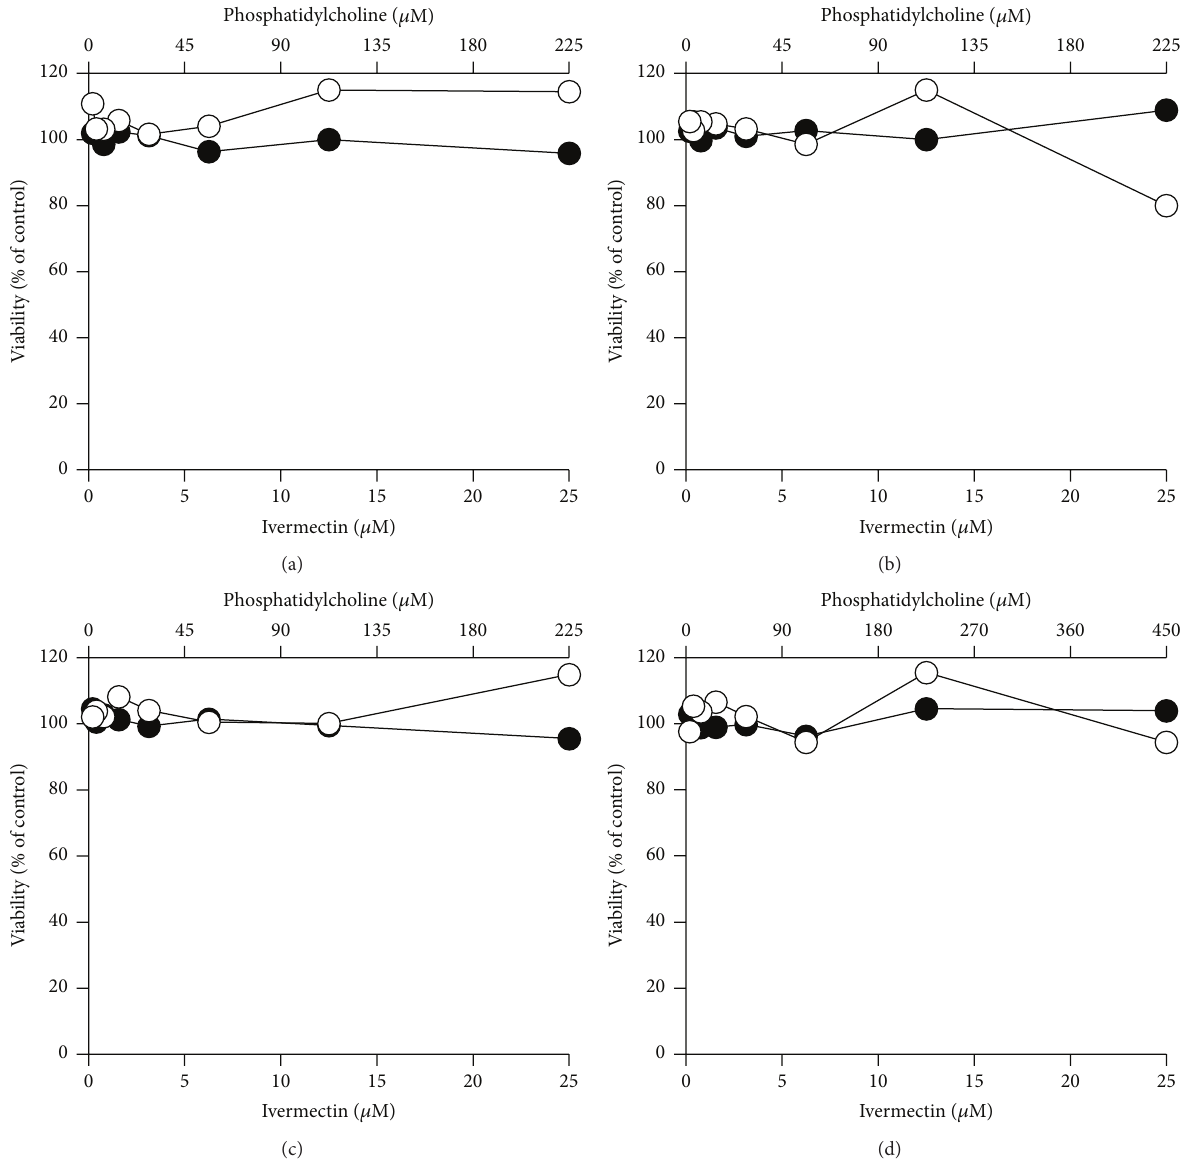
Figure 7: In vitro cytotoxicity effect of ivermectin formulated in liposomes (closed circles) on Vero-F cells. For comparison the same experiments were performed using empty liposomal formulations (open circles). The following liposomal formulations were tested: #PC9- Ch1 and #PC9-Ch1-ive1.0 (a), #PC9-Br1 and #PC9-Br1-ive1.0 (b), #PC9-Br0.5 and #PC9-Br0.5-ive1.0 (c), and #PC18-Br1 and #PC18-Br1-ive1.0 (d). The phosphatidylcholine concentration (top 𝑥 -axis) is related to empty liposomes while the ivermectin concentration (bottom 𝑥 -axis) is related to ivermectin liposomes. Details on the identification codes and liposomal compositions are included in Table 1. Data represent the average of 2 determinations.